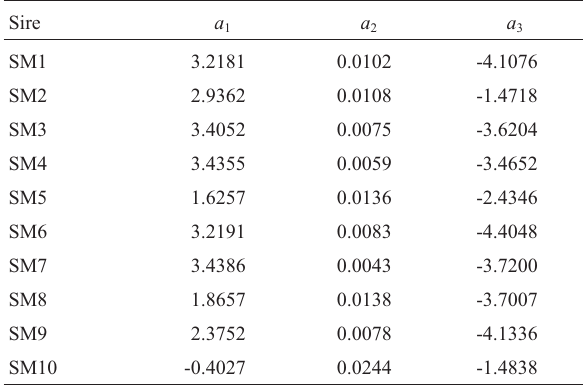
Table1 -Mean±standarddeviation(SD)andrangeofestimatedbreeding values for persistency of lactation (PS 1 to PS 6 ), 305-day milk yield (305MY) and random regression genetic coefficients ( a 1 , a 2 and a 3 ) of the Wilmink function for the sires of a population of Holstein cows. Traits